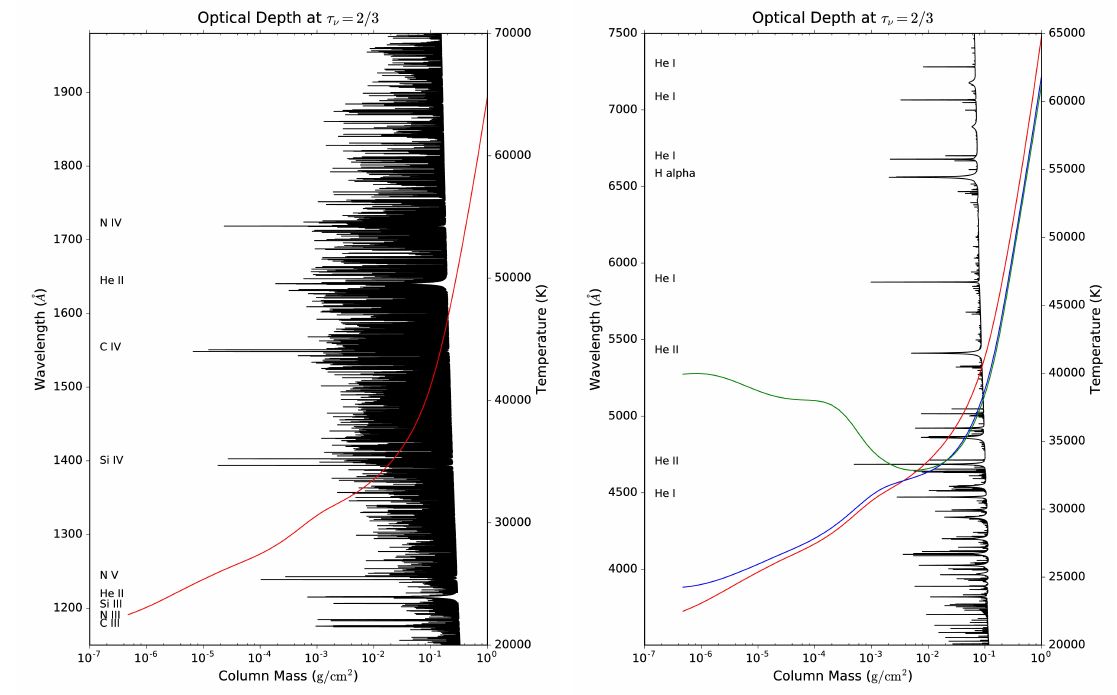
Figure 4. Left: temperature stratification and monochromatic optical depth τ ν = 2/3 as functions of column mass density for the final fully line-blanketed model defined by T eff = 42484K, log g = 5.6, and log N ( He )/ N ( H ) = 0.62. Right: The temperature stratification for models including H+He only (green), N (blue) and a fully line-blanketed model (red) is shown in the optical range, as well as τ